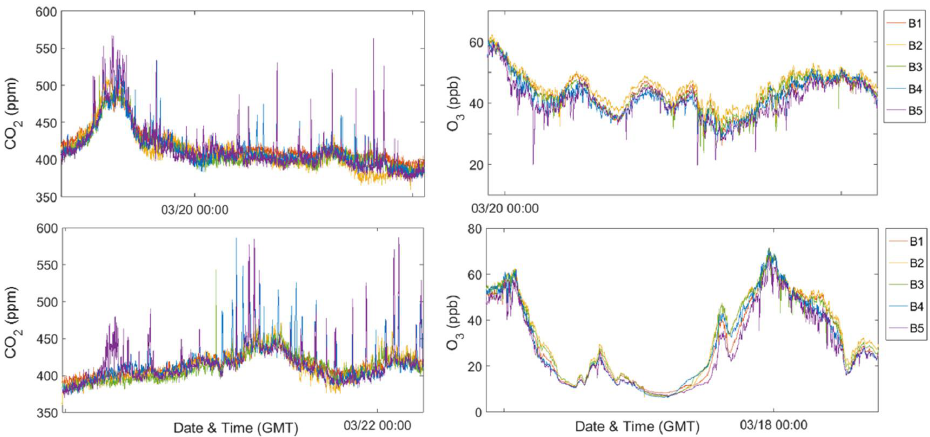
Figure 9. Time series of CO 2 data ( top and bottom left ) and O 3 data ( top and bottom right ), each showing approximately one-day of data from the building-sites during the Week 2 period.